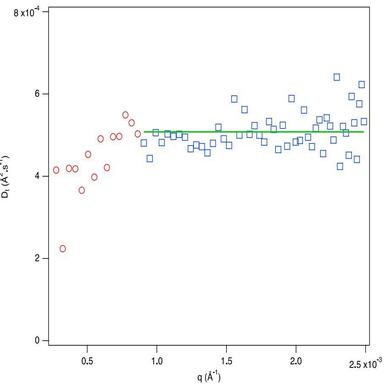
Dt as a function of scattering vector for the data shown in 16 assuming the first term of eq. dominates. As can be seen, the approximation is not valid at low q (red circles), but is valid for q > 9 × 10− 4 ˚A − 1 (blue squares) where the diffusion coefficient is constant. Averaging the values over this range (as indicated by the horizontal green line) yields Dt = (5.08 ± 0.45) × 10− 4 ˚A 2 .s− 1.